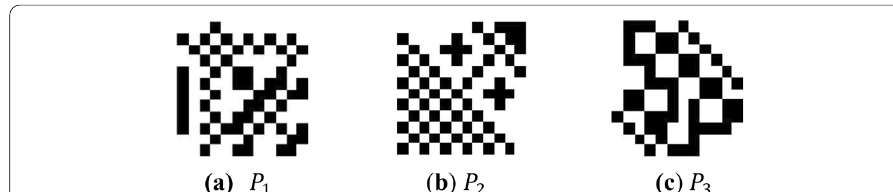
Fig. 9 The three texture patterns used in [19]. Each black or white dot is related to a pixel